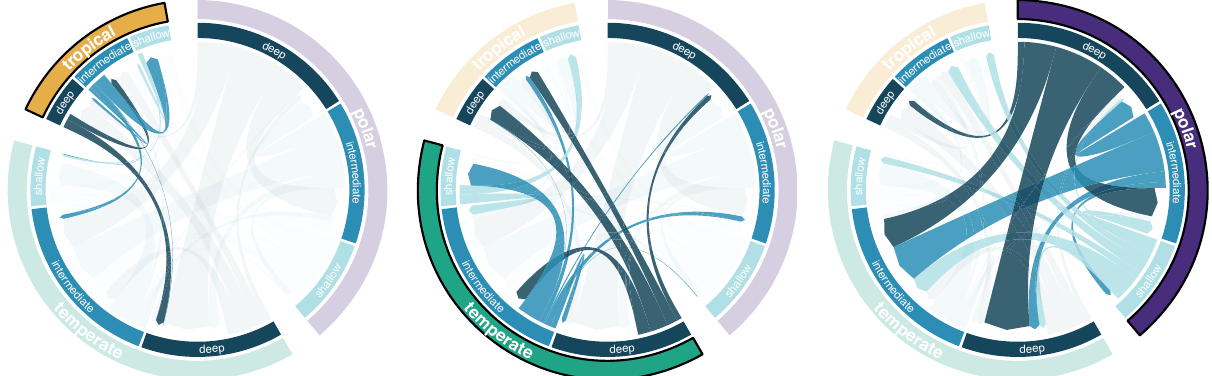
Fig. 3 | Invasions of the deep sea are predominantly found in high latitudes, concordant with a greater number of transitions across the depth gradient. Directionality of transitions across both depth and latitude estimated from the best- fi t Mk model (ARD). Maximum chord width corresponds to the estimated